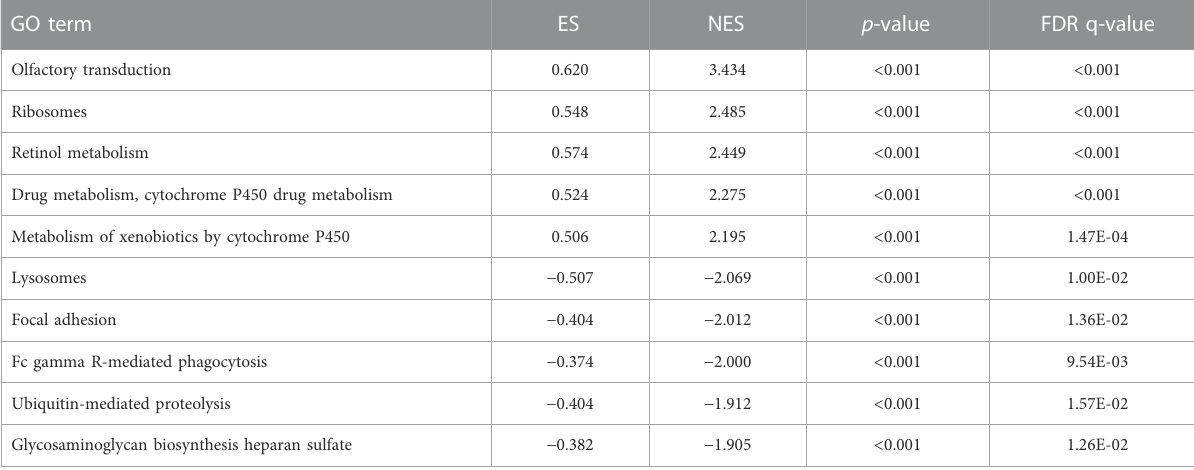
TABLE 6 Top fi ve enriched GO terms in the high-risk group and in the low-risk group.